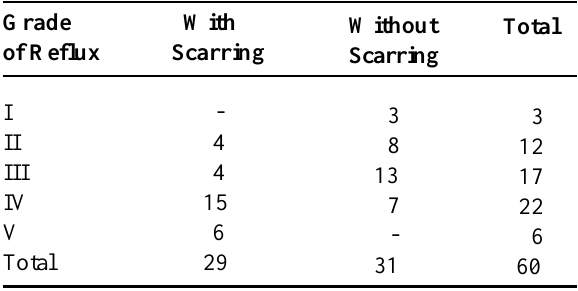
Table 2 – Correlation between the grade of vesicoureteral reflux and the presence of renal scarring by